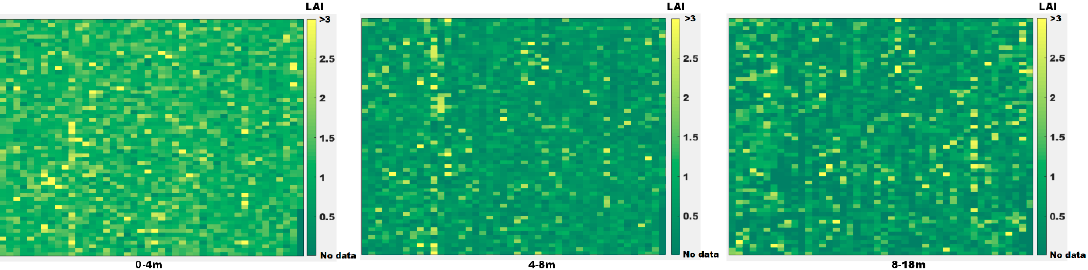
Figure 12. Histogram of effective LAI from GLAS data over Heilongjiang Province.